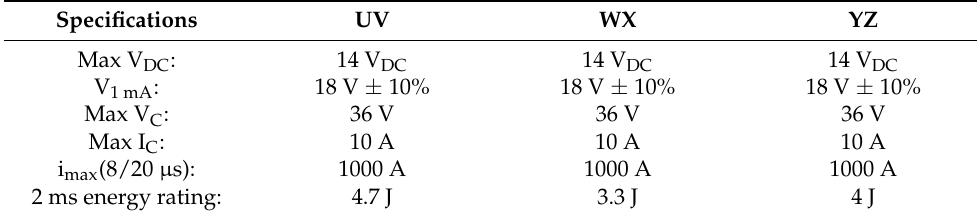
Table 1. Selected manufacturer metal oxide varistor device specification rating